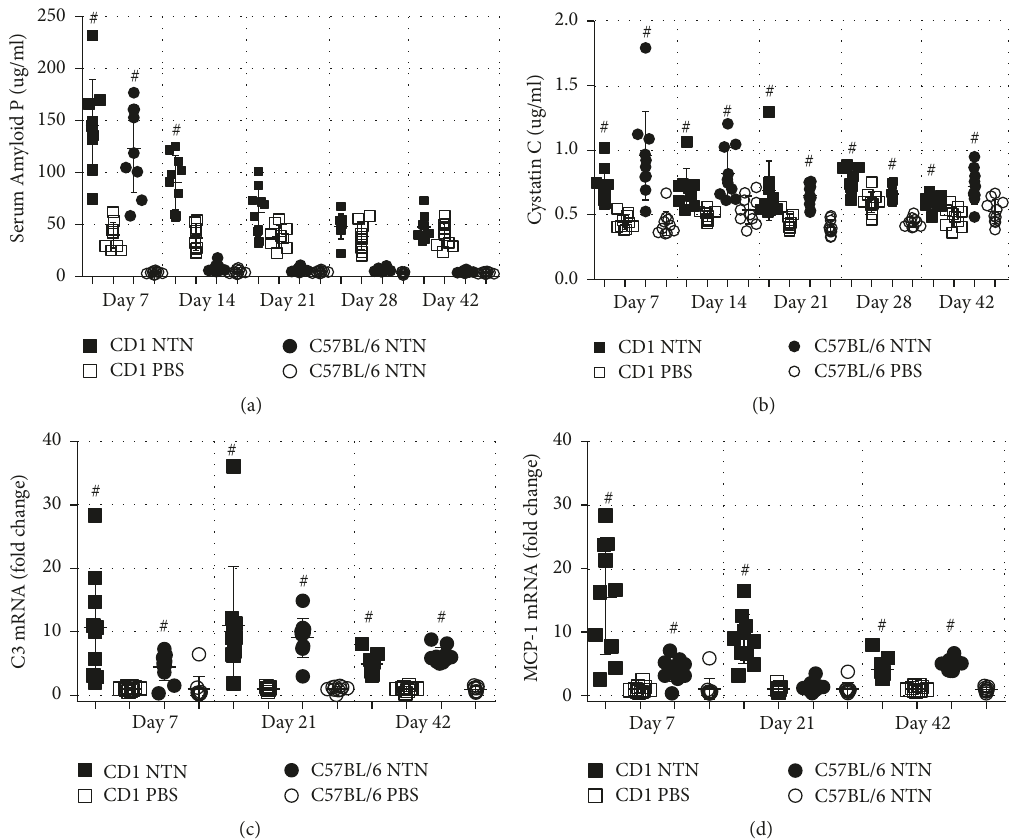
Figure 6: NTS induces systemic inflammation and elevation of GFR marker . (a) Scatter plot showing the SAP plasma concentration on days 7, 14, 21, 28, and 42 measured by ELISA. (b) Scatter plot of Cystatin C plasma concentration days 7, 14, 21, 28, and 42 measured by ELISA. (c) Scatter plot showing mRNA expression in whole kidney tissue of C3 and MCP-1 (CCL2) on days 7, 21, and 42, expressed as fold change. Data are shown as mean ± SD. # 𝑃 < 0.001 NTN groups versus PBS groups by two-way ANOVA ( 𝑛 = 10 ).